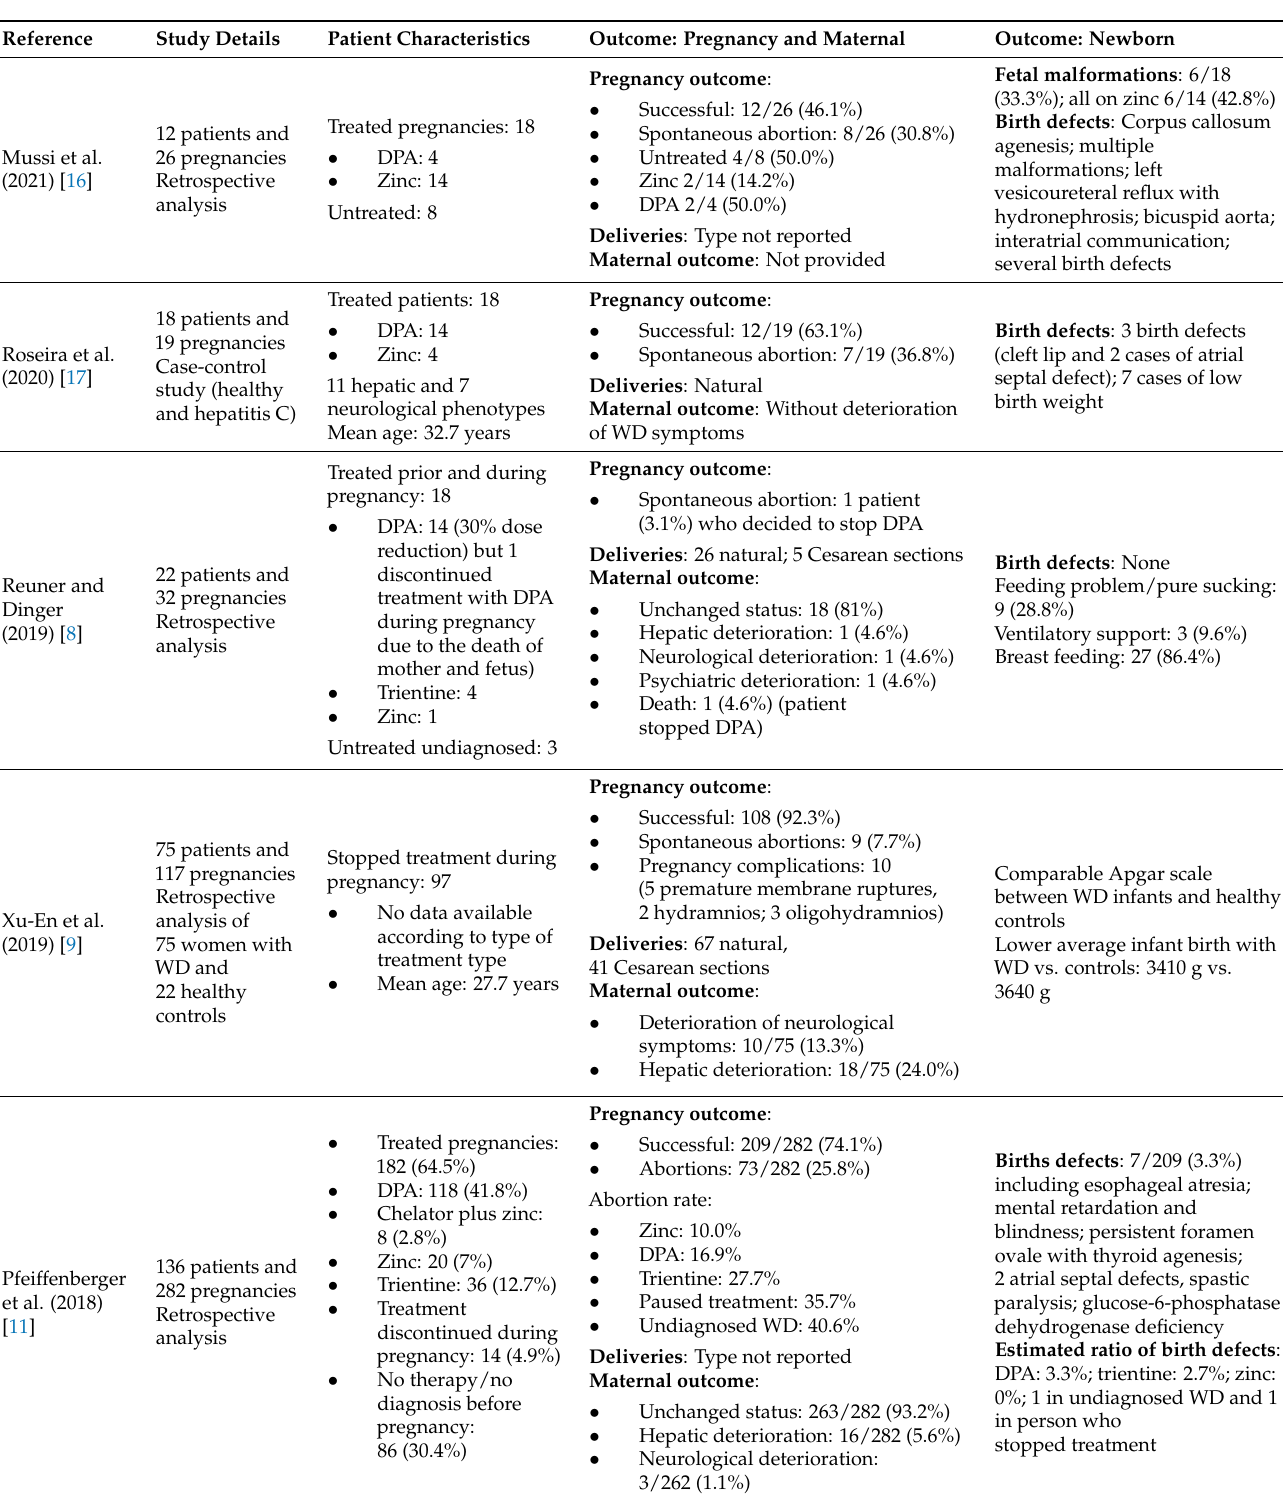
Table 1. Summary of studies of pregnant patients with Wilson’s disease according to the time of diagnosis, anti-copper treatment, pregnancy and delivery complications, maternal and newborn outcomes, and birth